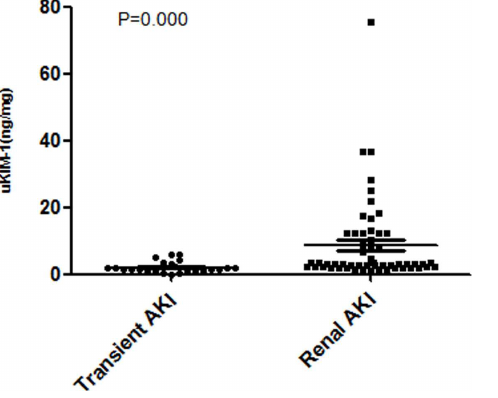
Fig 2. The uKIM-1 level in the transient AKI group was significantly higher than that of the non transient AKI group among elderly AKI patients during the occurrence of